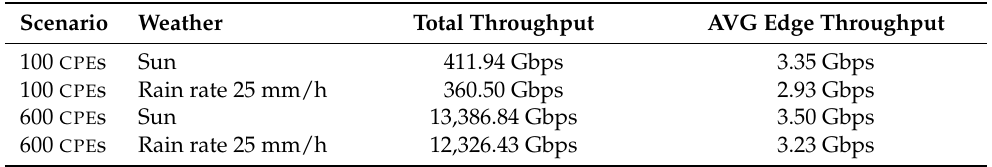
Table 7. Influence of rain attenuation on total and average (AVG) network throughput of an IEEE Std 802.11ad system at 60